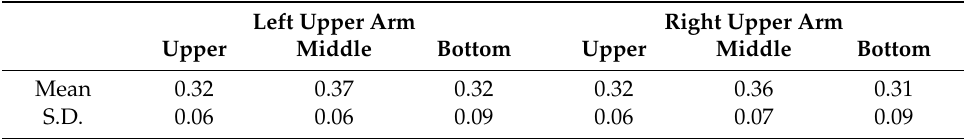
Table 3. Estimated BMDs from premature infant radiographs. The regions of interest (ROIs) include the upper, middle, and bottom parts of the humerus in the left and right upper arms (in g / cm 2 ). Left Upper Arm Right Upper Arm Upper Middle Bottom Upper Middle